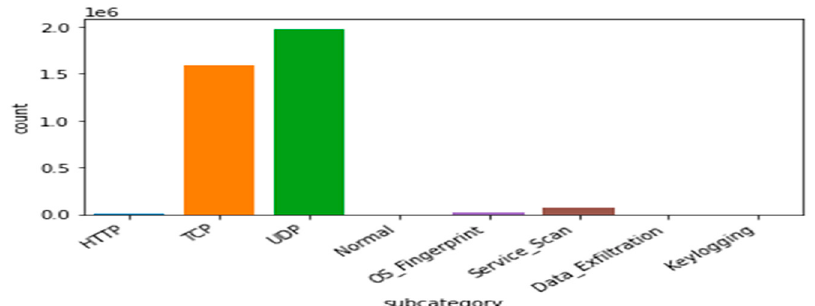
Figure 7. Statistics of considered attacks (the subcategory) (count is 1 × 1 to the 6th). Table 5. Attack types selected from the BoT-IoT